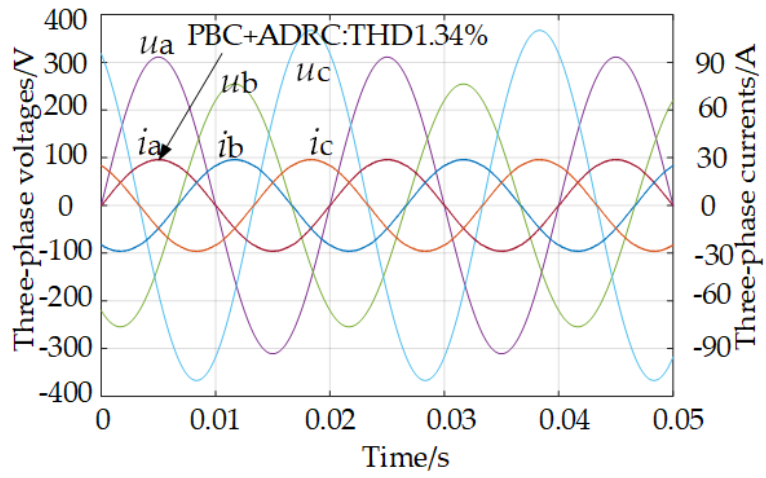
Figure 4. Three − phase unbalanced grid voltages (unequal amplitude) and three − phase input 4. currents.